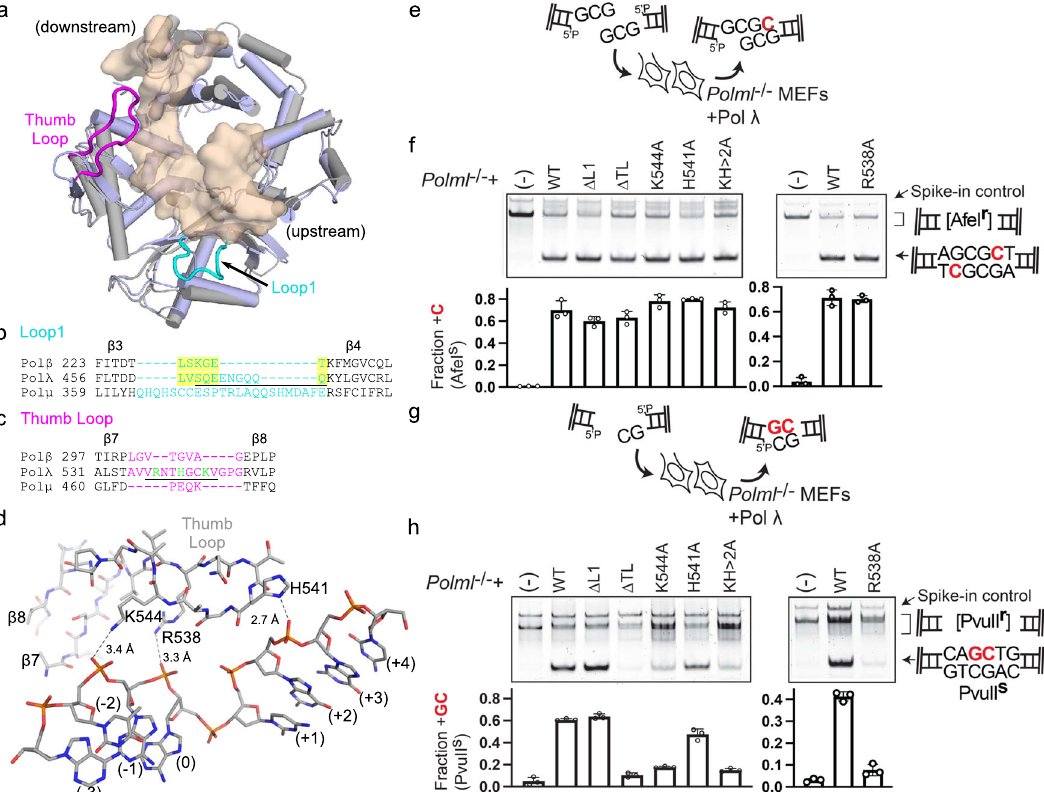
Fig. 3 Determinants of DSB substrate speci fi city by Pol λ . a Structural superposition of 1nt SSB crystal structures of Pol λ (PDB ID code 1XSN 11 , protein in gray and DNA in transparent khaki surface) and Pol μ (PDB ID code 4M04 12 , protein in light blue). Loop1 and the ‘ thumb loop ’ regions of Pol λ are shown in cyan and magenta, respectively. b Structure-based sequence alignment of Loop1 (cyan) in Pols β , λ , and μ (structurally-equivalent regions highlighted in yellow). The Pol λ Δ L1 variant was generated by deleting Ser463-Gln471 (underlined) and replacing them with Lys462-Thr465 from Pol β 13 . c Sequence alignment of ‘ thumb loop ’ (TL, magenta) of Pols β , λ and μ . The Pol λ Δ TL variant was generated by deleting Val537-Val545 of Pol λ (underlined) and fusing the ends of β -strands 7 and 8 with a single glycine residue. Thumb loop mutations used in this study are marked in green. d Interactions of the TL with an SSB substrate (PDB ID code 1XSN 11 , gray). Hydrogen bonds with the DNA template strand are shown as black dashed lines. e DNA fragments with partly complementary ends (GCG3 ʹ overhangs) were introduced into Polm − / − Poll − / − cells ( Polml − / − ). f Representative gel electrophoresis (top) identi fi cation of the fraction of NHEJ that is AfeI-sensitive and polymerase-dependent. Quanti fi cation of the average fraction of polymerase-dependent repair using GCG3 ʹ DSB substrates from triplicate electroporations (bottom; error bars represent the standard deviation). g As in ( e ), except using noncomplementary blunt and GC3 ʹ overhangs. h As in ( f ), except using PvuII sensitivity to identify polymerase-dependent